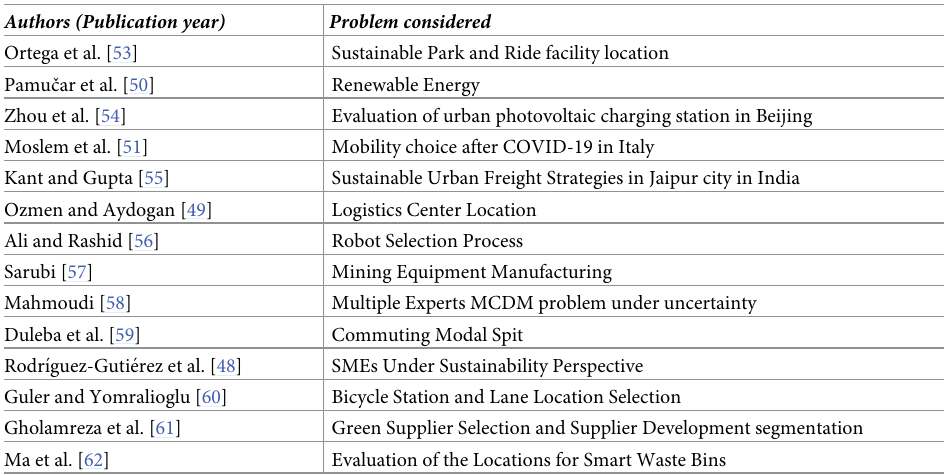
Table 2. Applications of the Best-Worst Method